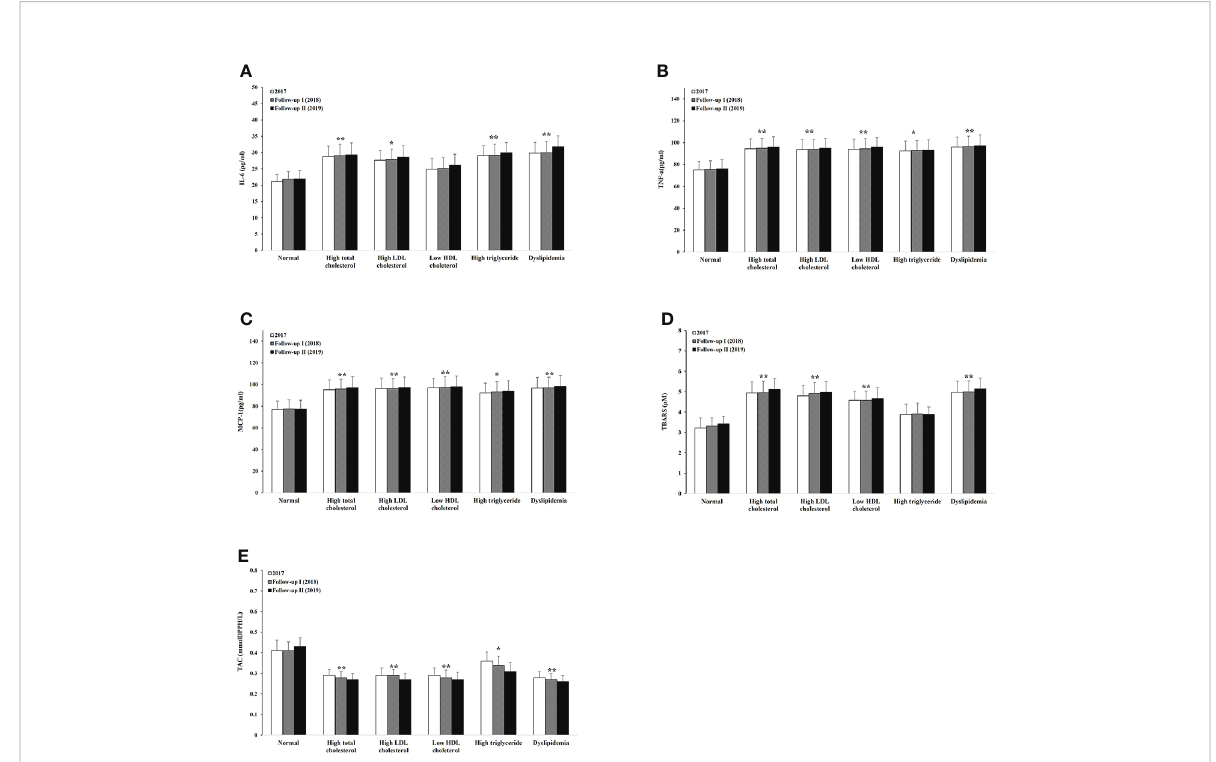
FIGURE 3 Serum levels of proin fl ammatory cytokines, oxidative stress, and antioxidant capacity within different lipid abnormalities among male adults. IL- 6 (A) , TNF- b (B) , MCP-1 (C) , TBARS (D) , and TAC (E) . Logistic regression analysis indicated: * p < 0.05, ** p < 0.01 overall difference vs. the level of lipid normal group.